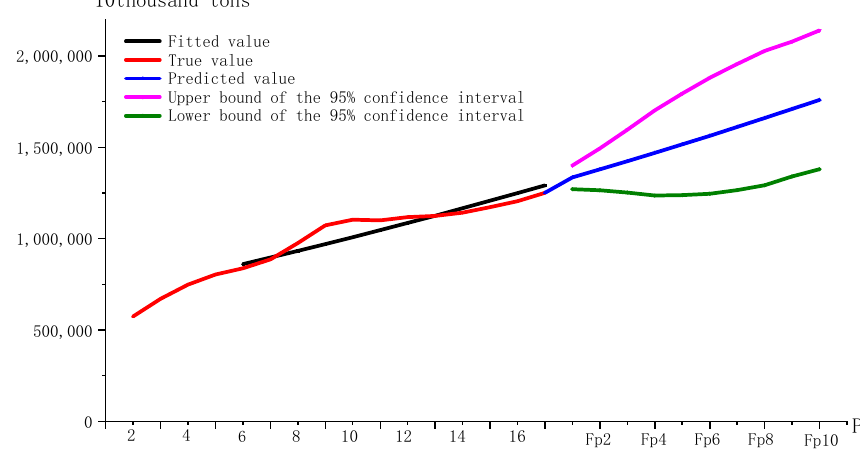
Figure 2. Error analysis of carbon emission prediction models.